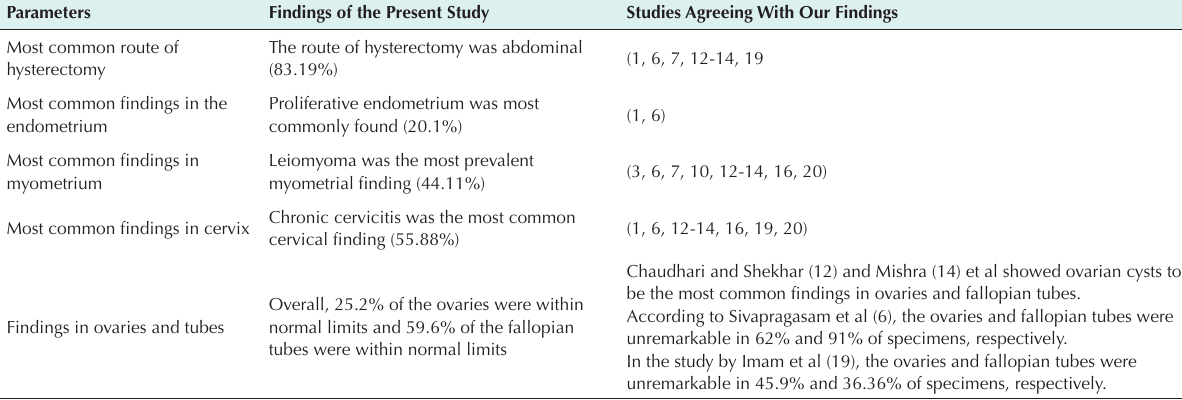
Table 5. Studies Agreeing With the Current Study